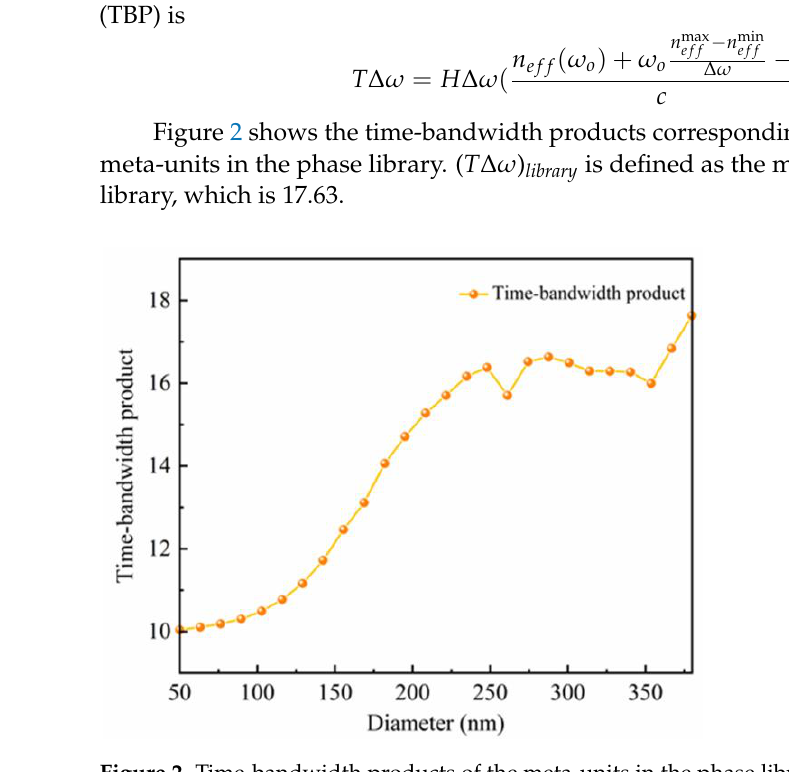
Figure 2. Time-bandwidth products of the meta-units in the phase library.